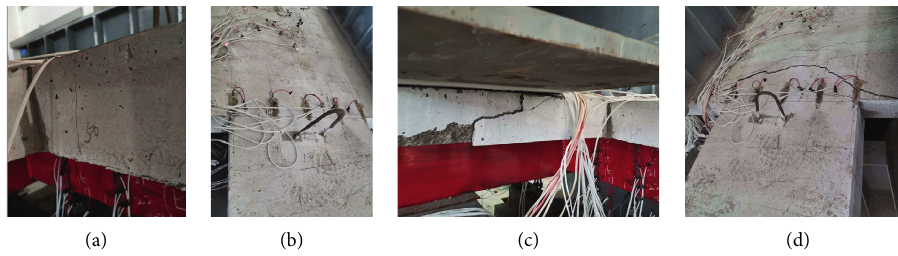
Figure 8: Destruction process and failure pattern of Specimen BGJ2.